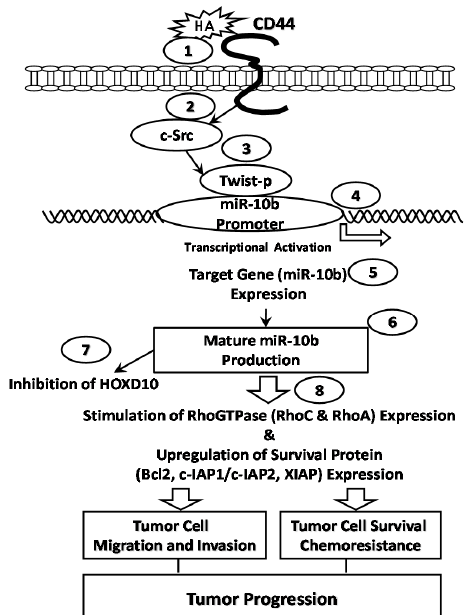
Figure 5. HA-CD44 interaction promotes c-Src and Twist activation and miR-10b expression during tumor cell migration/invasion and chemoresistance: In the c-Src-Twist signaling pathway, HA